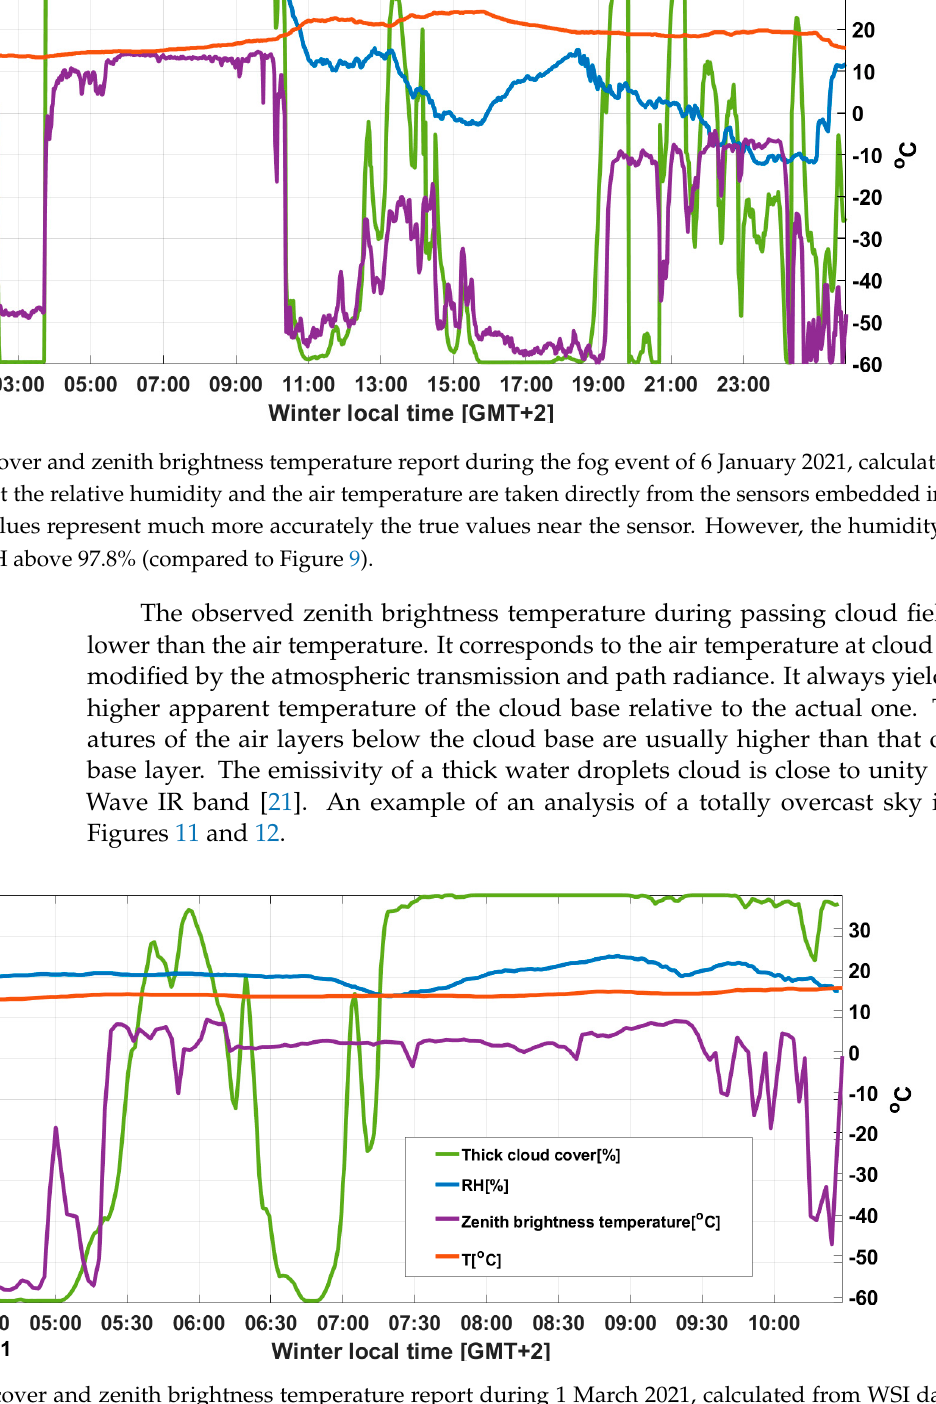
Figure 12. Sky image on 1 March 2021. ( a ) 06:52—The very initial buildup phase. The sky begins to cover from the northwest direction. ( b ) 07:15—In the middle of the buildup phase. The original buildup direction is still apparent. ( c ) 07:51—At the end of the buildup phase. Some isolated clear sky patches are clearly seen. ( d ) 09:39—The cloud covers the sensor’s entire field of view. This case study nicely demonstrates the difference between the evolution and the appearance of foggy and cloudy skies. First, fully overcast skies evolve on significantly longer time scales relative to fog (tens instead of a few minutes). As in any typical cloud field, the cloud cover builds up gradually in time with the local geometry playing an ap- preciable role in its appearance. During the buildup phase, the cloud cover may change its pace and can even temporally retreat. In addition, during this phase, low emissivity clouds are also present in the field of view. Second, from the ground level field of view, most clouds are advected at the wind speed observed at their base height. Therefore, clouds begin to accumulate in the field of view from a specific direction. The azimuthal symmetry of the fog formation in the field of view (see Figure 6) is a unique feature of a